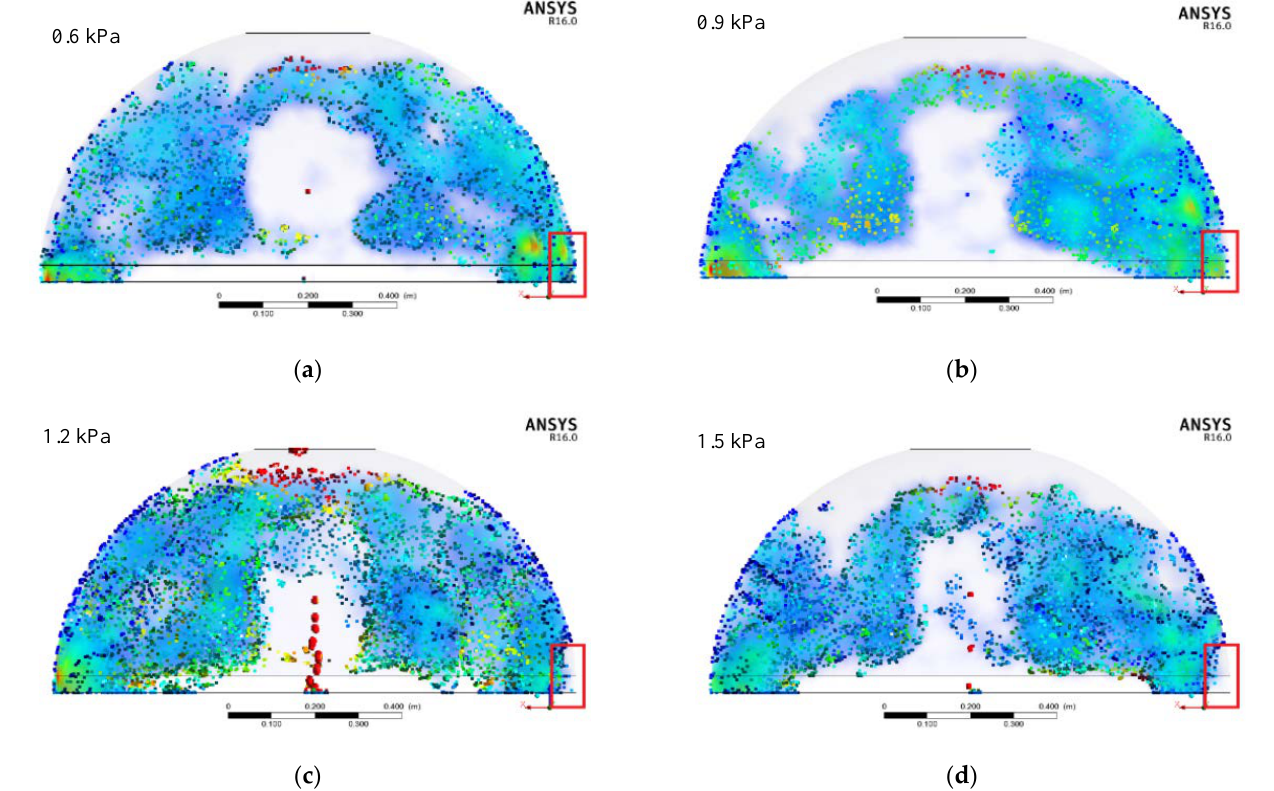
Figure 25. Distribution of the paint mist in recovery cover: ( a ) 0.6 kPa; ( b ) 0.9 kPa; ( c ) 1.2 kPa; ( d ) 1.5 kPa.